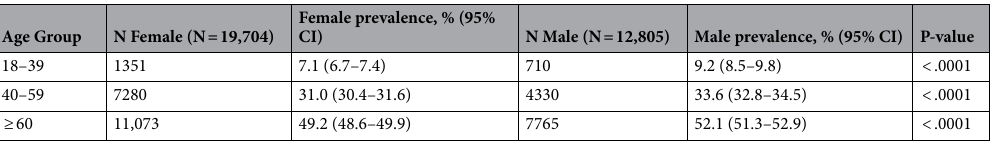
Table 3. Crude HTN prevalence in All of Us research program with age distribution in All of Us by gender.